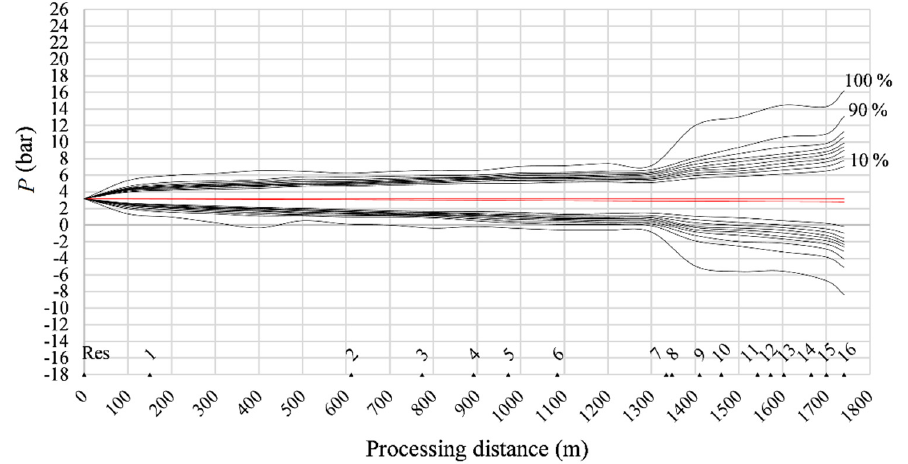
Figure 7. Pressure profile (Res-node 16) for 500 configurations, considering the simultaneous opening and closing of two different hydrants out of five.